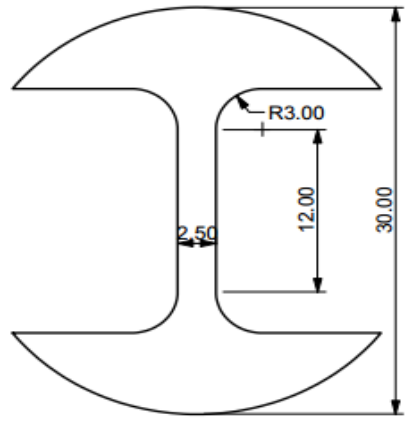
Figure 1. Schematic diagram of tensile sample and the thickness is 1.5 mm.